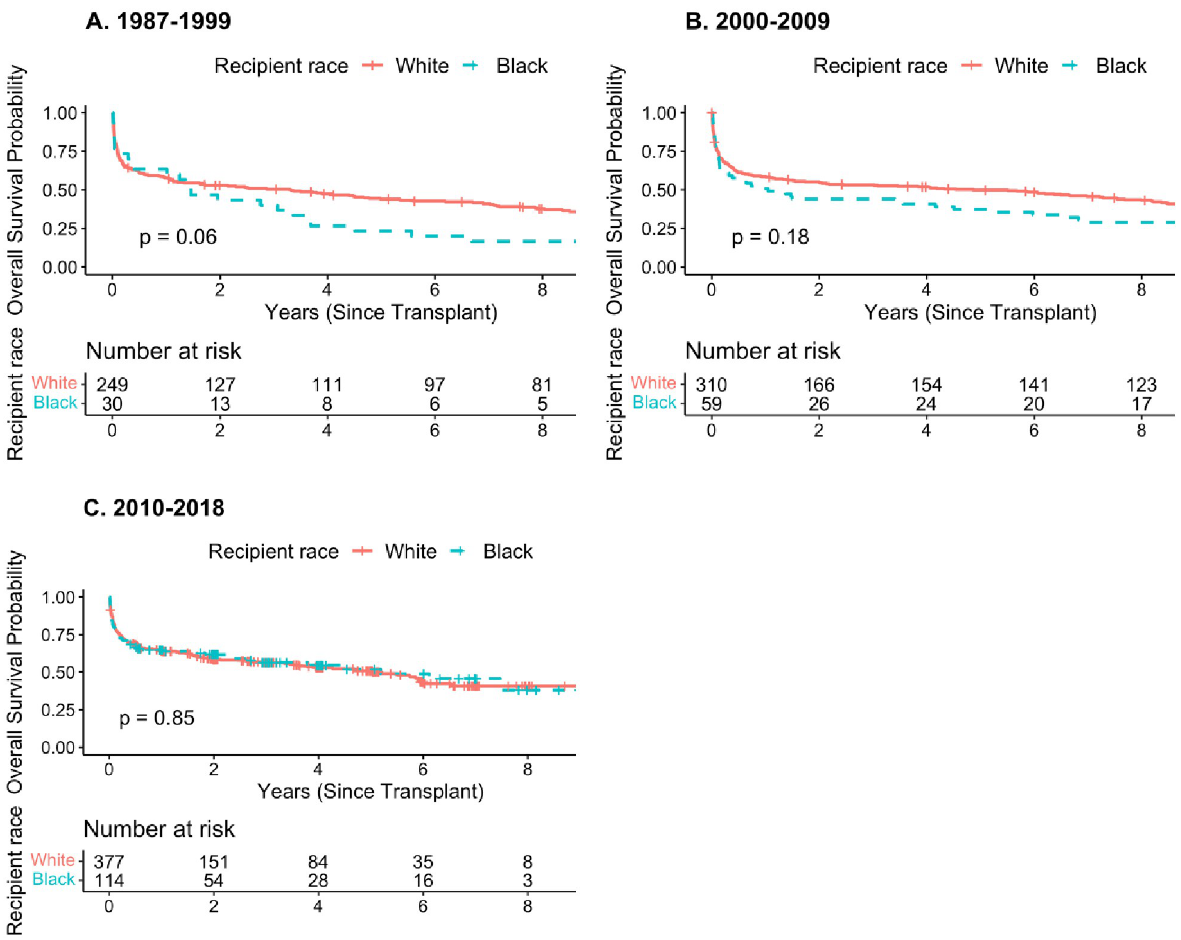
Fig 2. Kaplan Meier survival curves for post-transplant stroke survivors, hazard ratios and 95% confidence intervals comparing mortality rates for Black post-transplant stroke survivors to mortality rates for white post-transplant stroke survivors according to era, Scientific Registry Of Transplant Recipients (SRTR), January 1, 1987 To December 31, 2018 (a) within 6 months of cardiac transplant and (b) beyond 6 months until last follow-up conditional on surviving beyond 6 months.